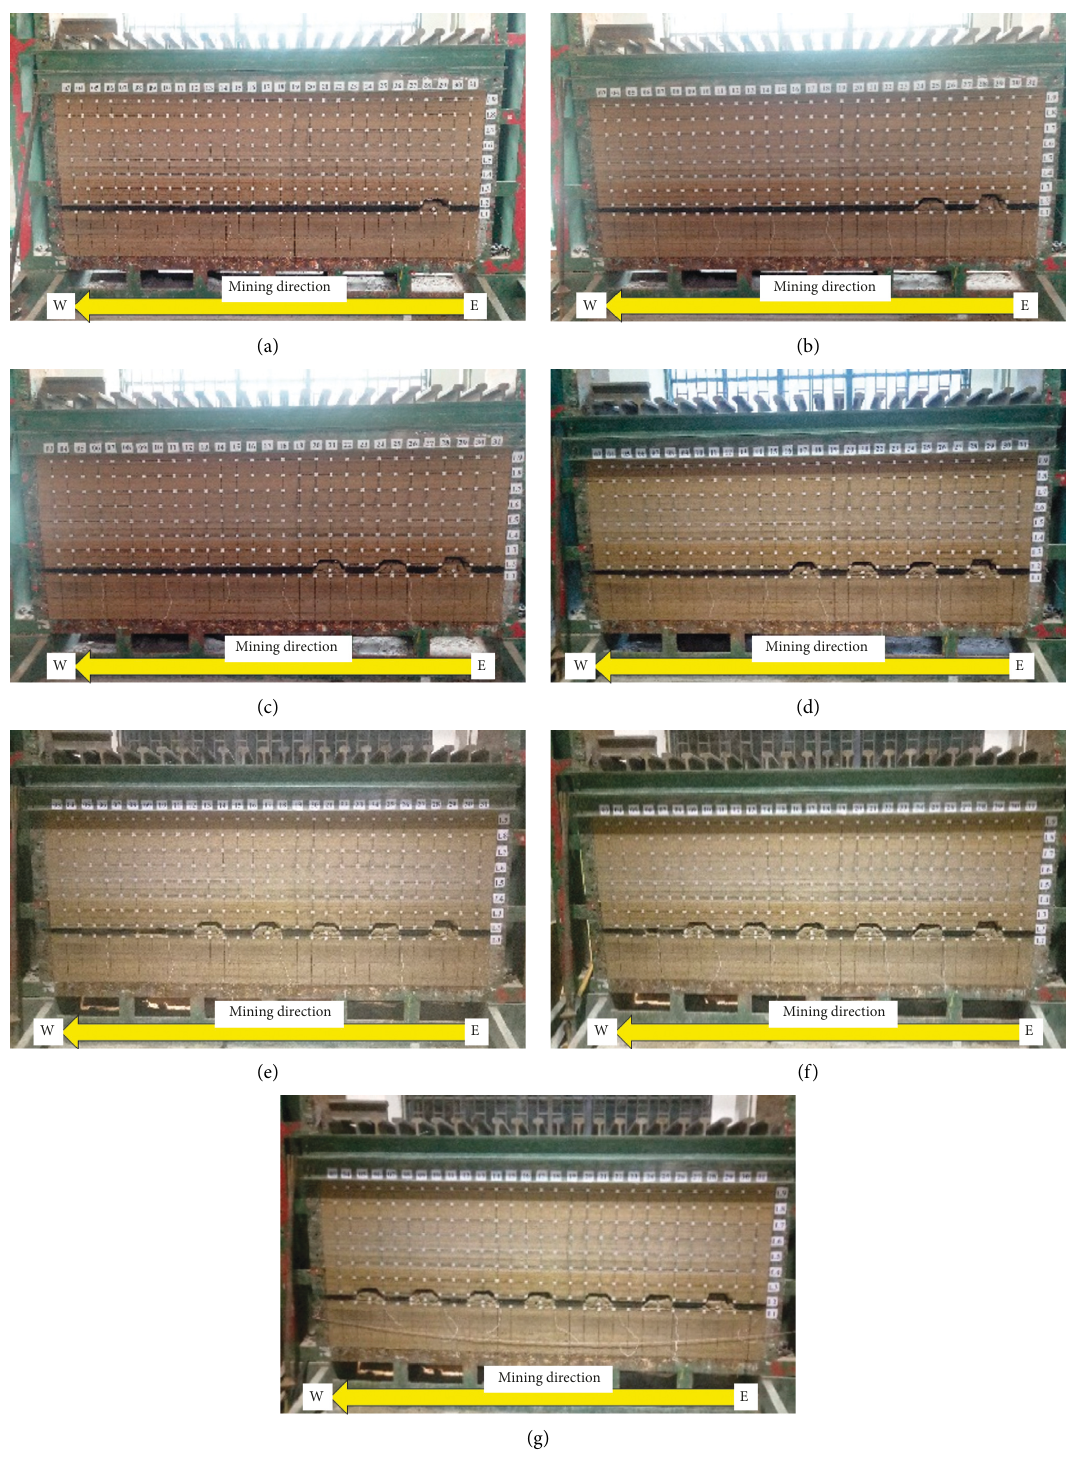
Figure 6: Process of sequential mining of strip working face. (a) 1# working face, (b) 2# working face, (c) 3# working face, (d) 4# working face, (e) 5# working face, (f) 6# working face, and (g) 7# working